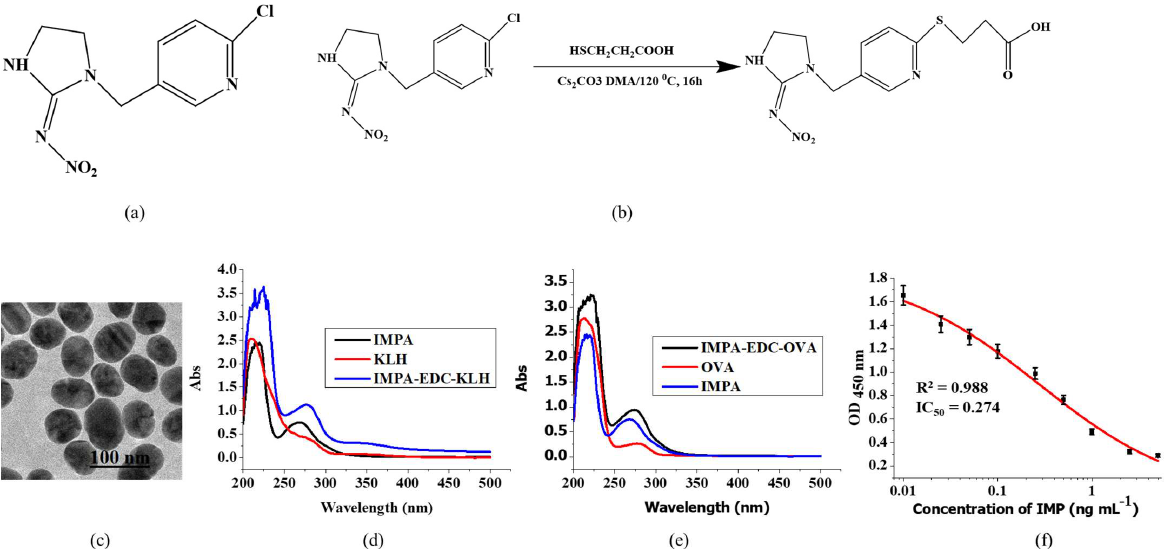
Figure 1. ( a ) Structure of IMP. ( b ) Preparation of IMP hapten. ( c ) Result of AuNPs by transmission electron microscopy (TEM). A diagram of the use of UV–vis spectra of IMP immunogens ( d ) and IMPA-EDC-OVA ( e ). Standard curves of IMP detection using ELISA ( f ).